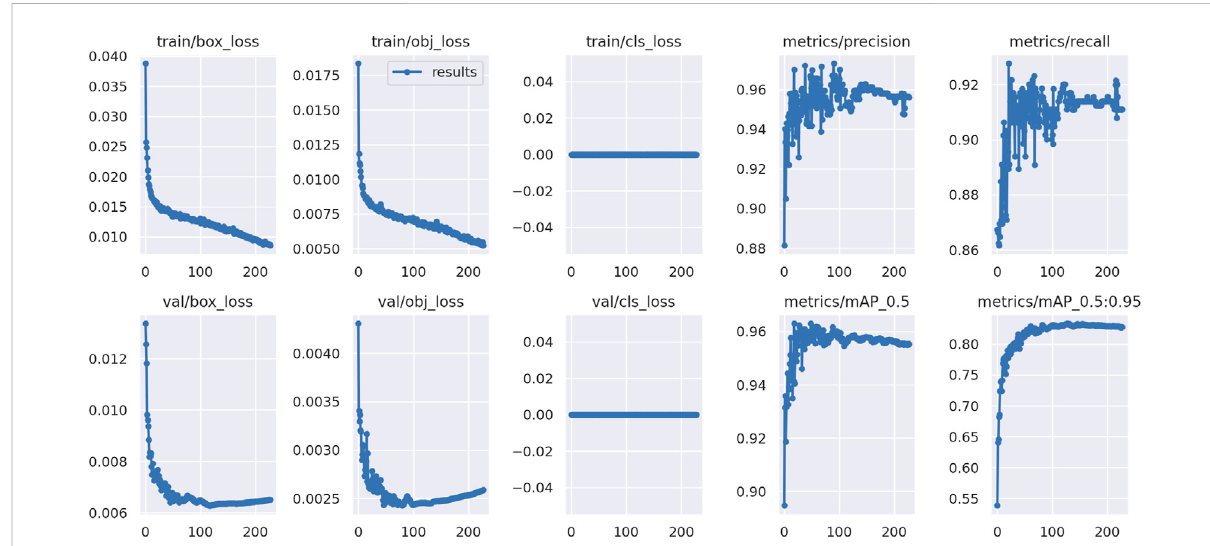
FIGURE 3 Vehicle detection YOLOv5 model training. Box regression loss (box loss), object loss (obj loss), class loss (cls loss), training accuracy, and recall are depicted in the top row, from the left to the right. Similar to the fi rst row, the fi rst three fi gures in the second row are loss functions for the validation set instead. The next two fi gures represent the mean average precision for IoU thresholds greater than 0.5 and for the range (0.5, 0.55, 0.60, ...,